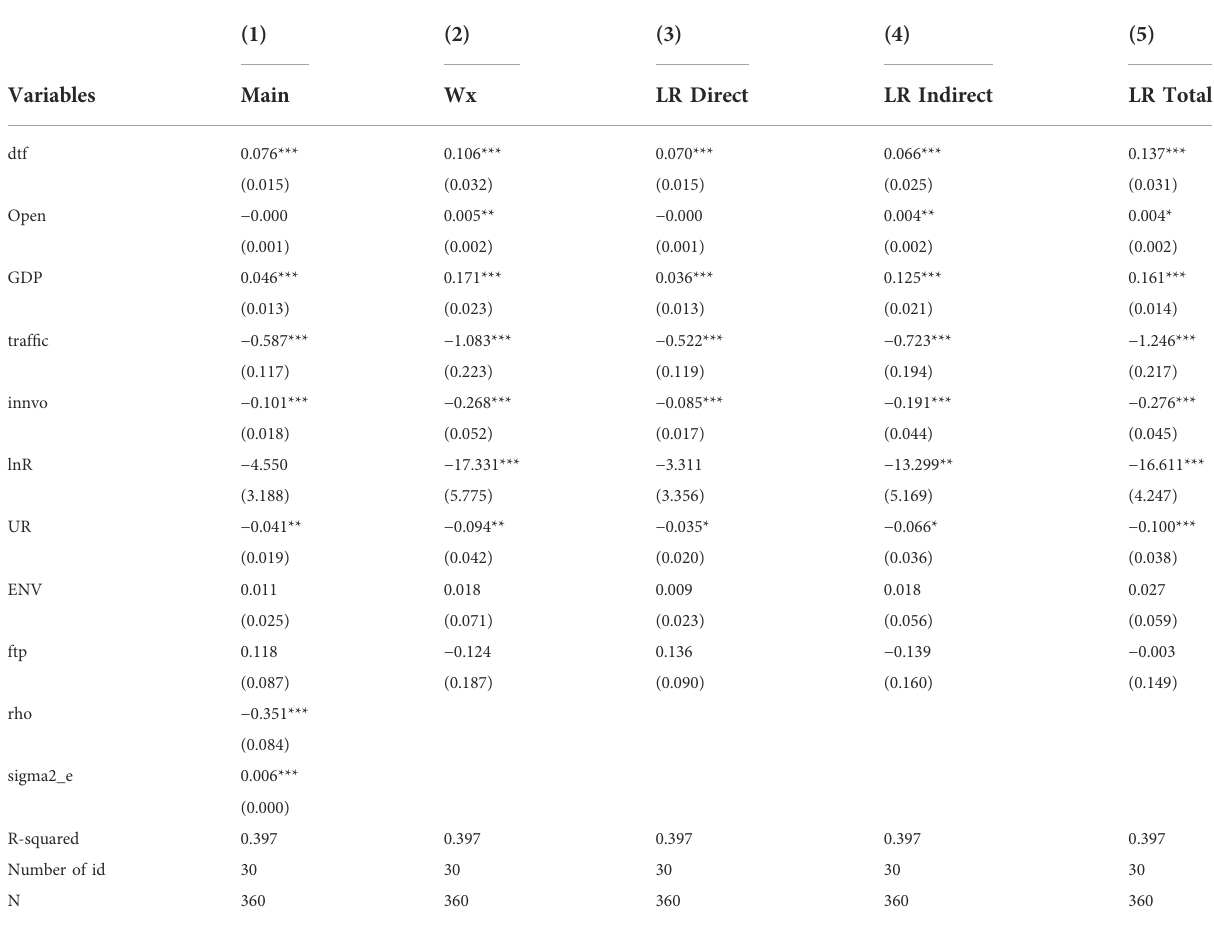
TABLE 9 Spatial Durbin model: business environment and human capital structural